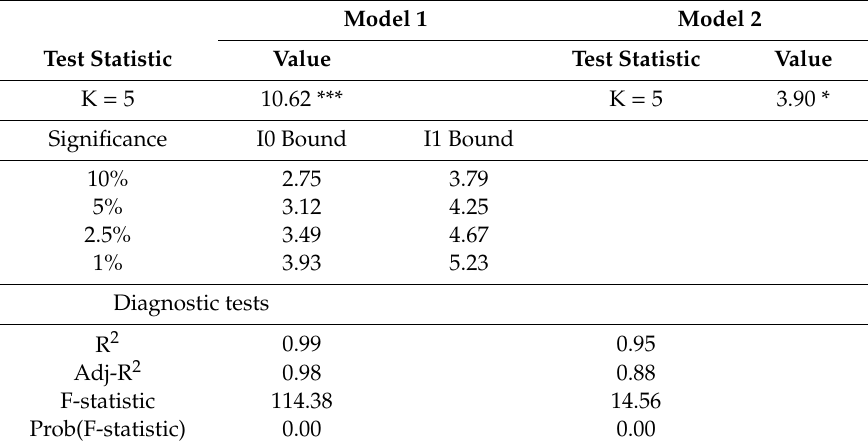
Table 9. ARDL bounds cointegration testing